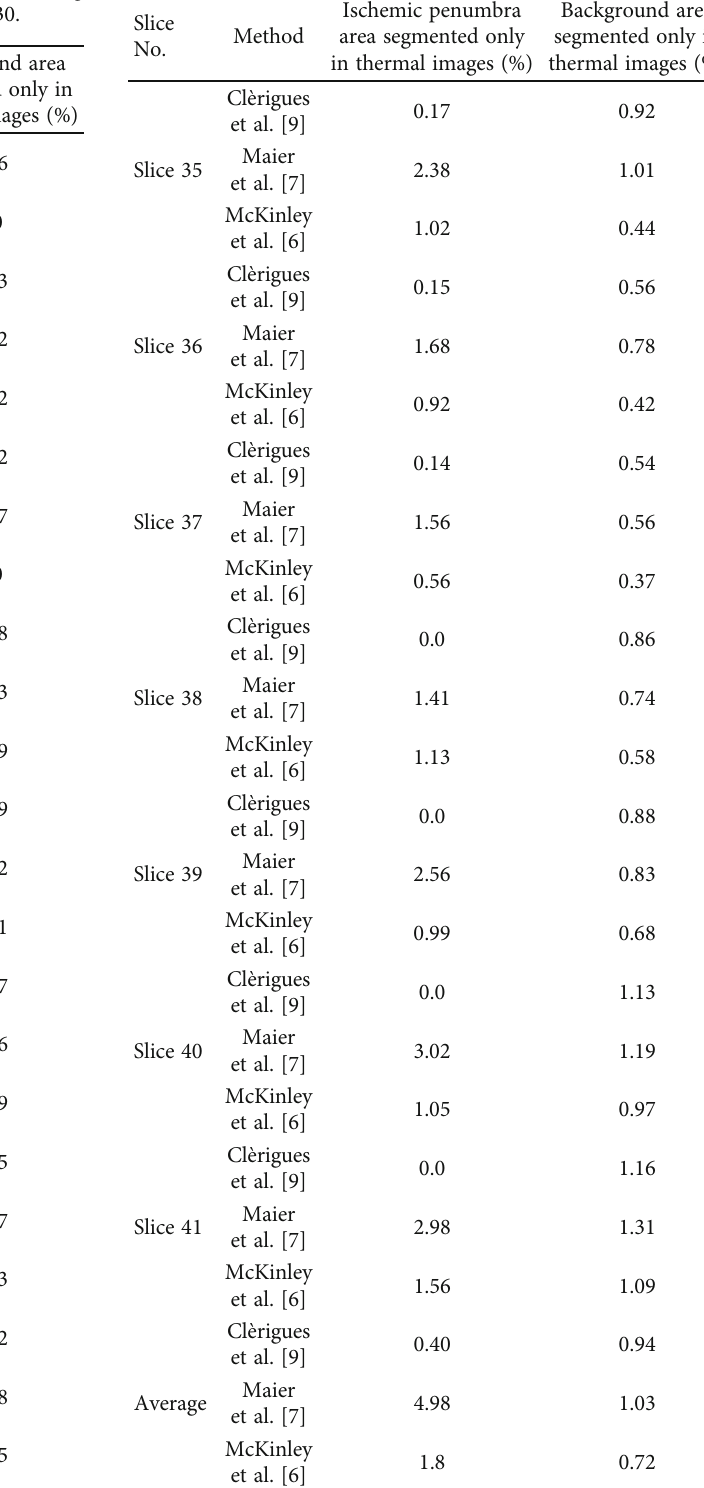
Table 5: The percentage of ischemic penumbra and background areas segmented in thermal images and not segmented using methods from the literature in slices taken from subject